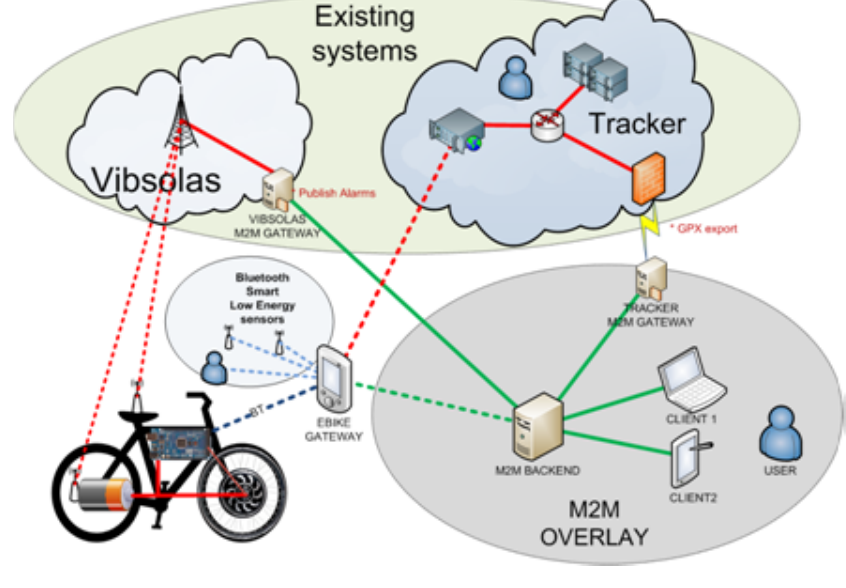
Figure 24. The main components of the electric bike experimental